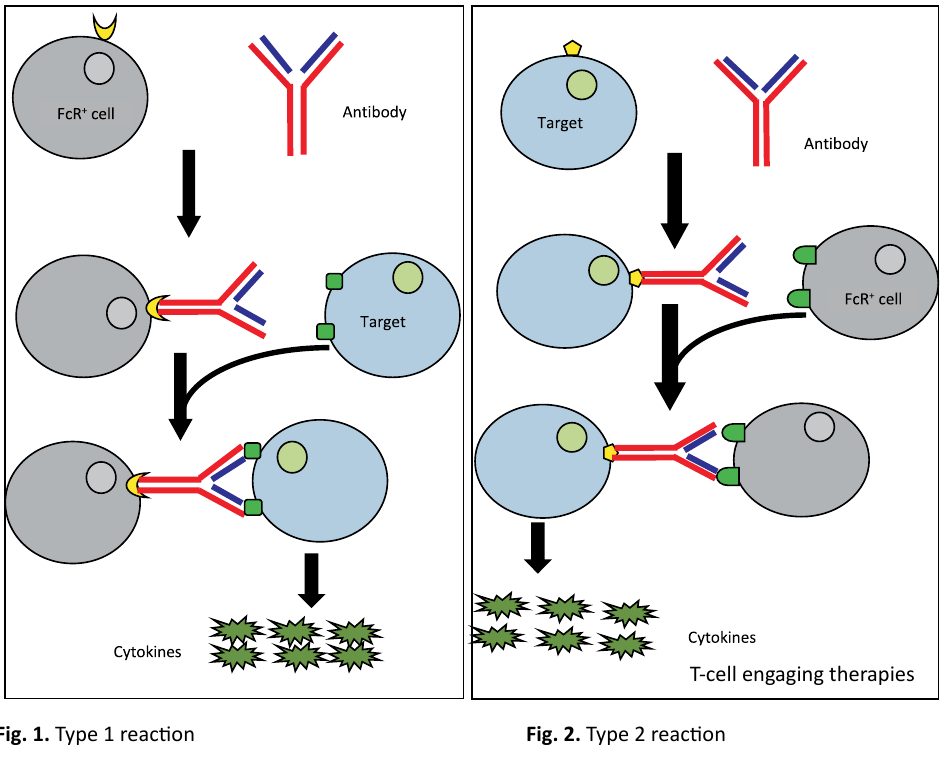
Fig. 1. Type 1 reaction Fig. 2. Type 2 reaction